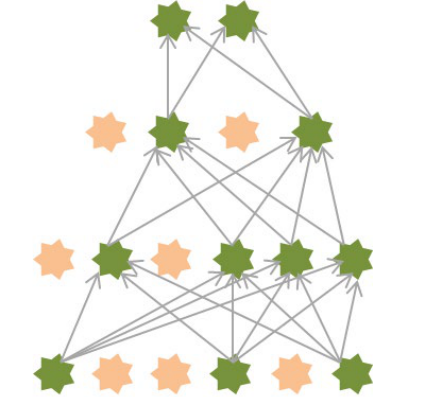
Figure 15 . Network with application of